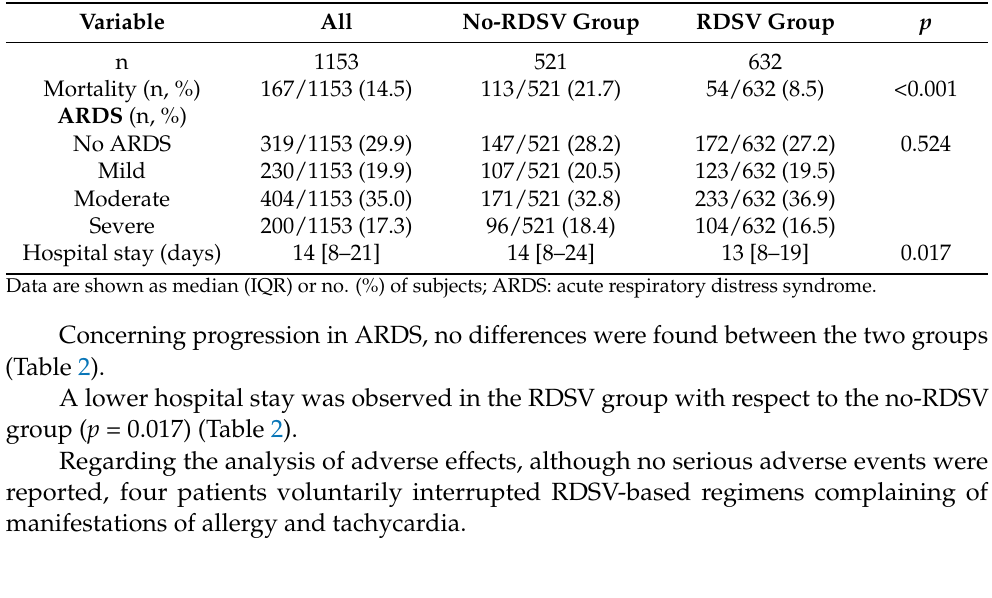
Table 2. Clinical progression of the study